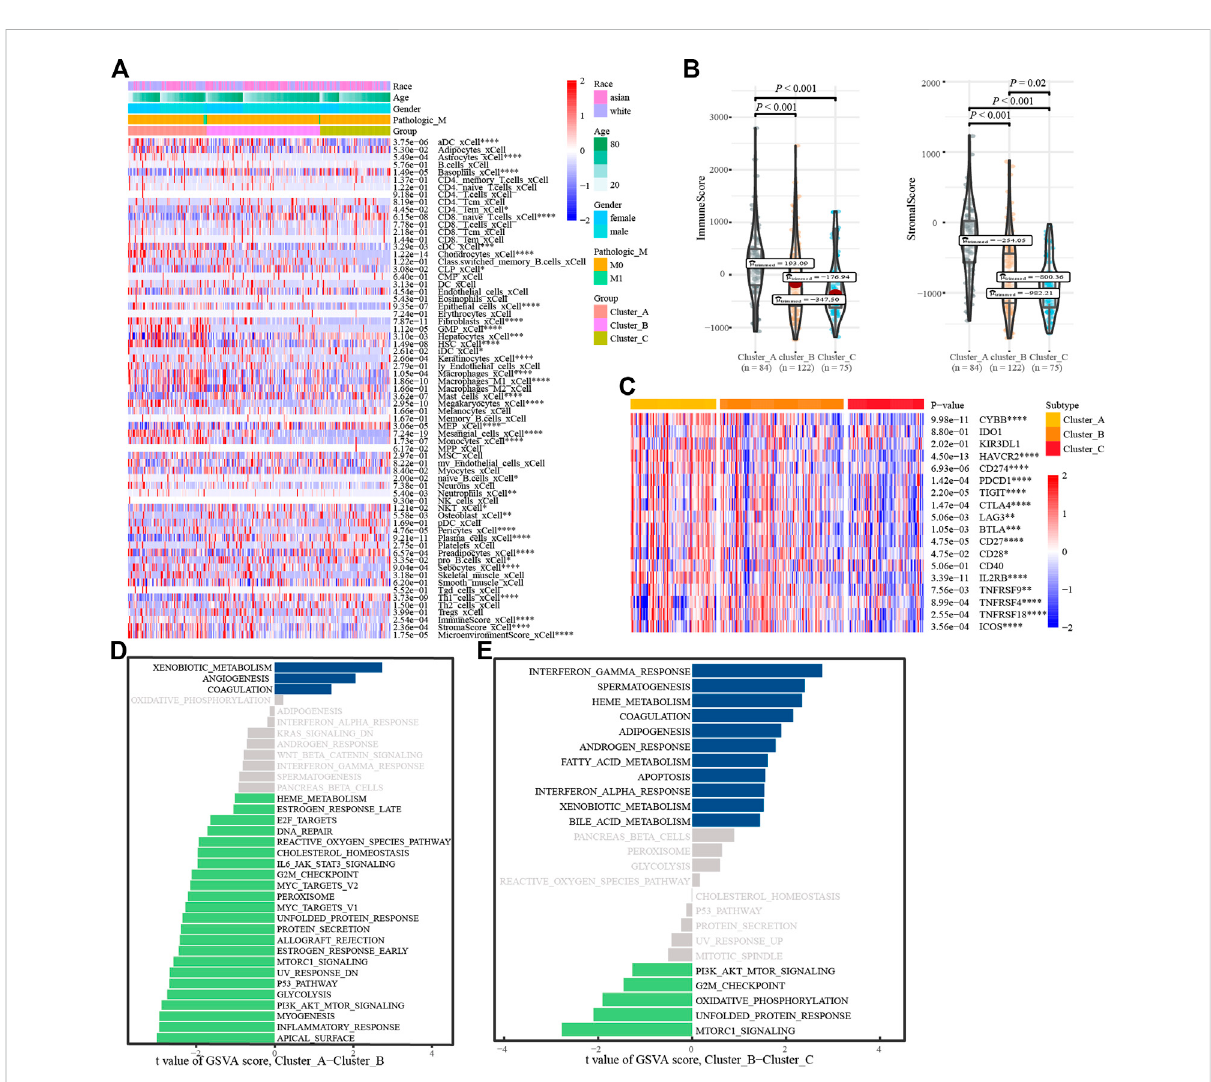
FIGURE 3 Glycosylation regulatory gene model. (A) . Conditional probability survival curve; (B) . Apply consensus clustering to construct a glycosylation regulator gene model; (C) . Kaplan-Meier survival analysis of the glycosylation regulator gene model; (D) . Calibration curve at 5 and 8 years; (E) .